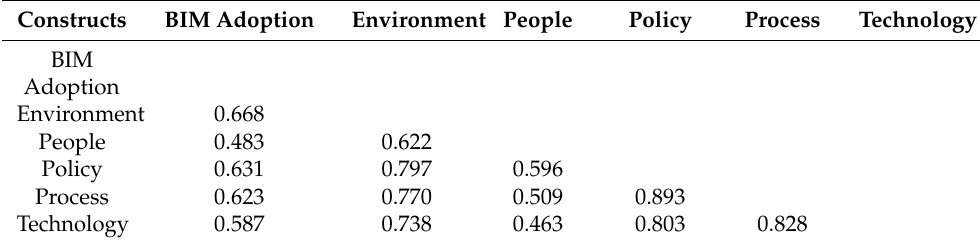
Table 7. Heterotrait–Monotrait Ratio Results